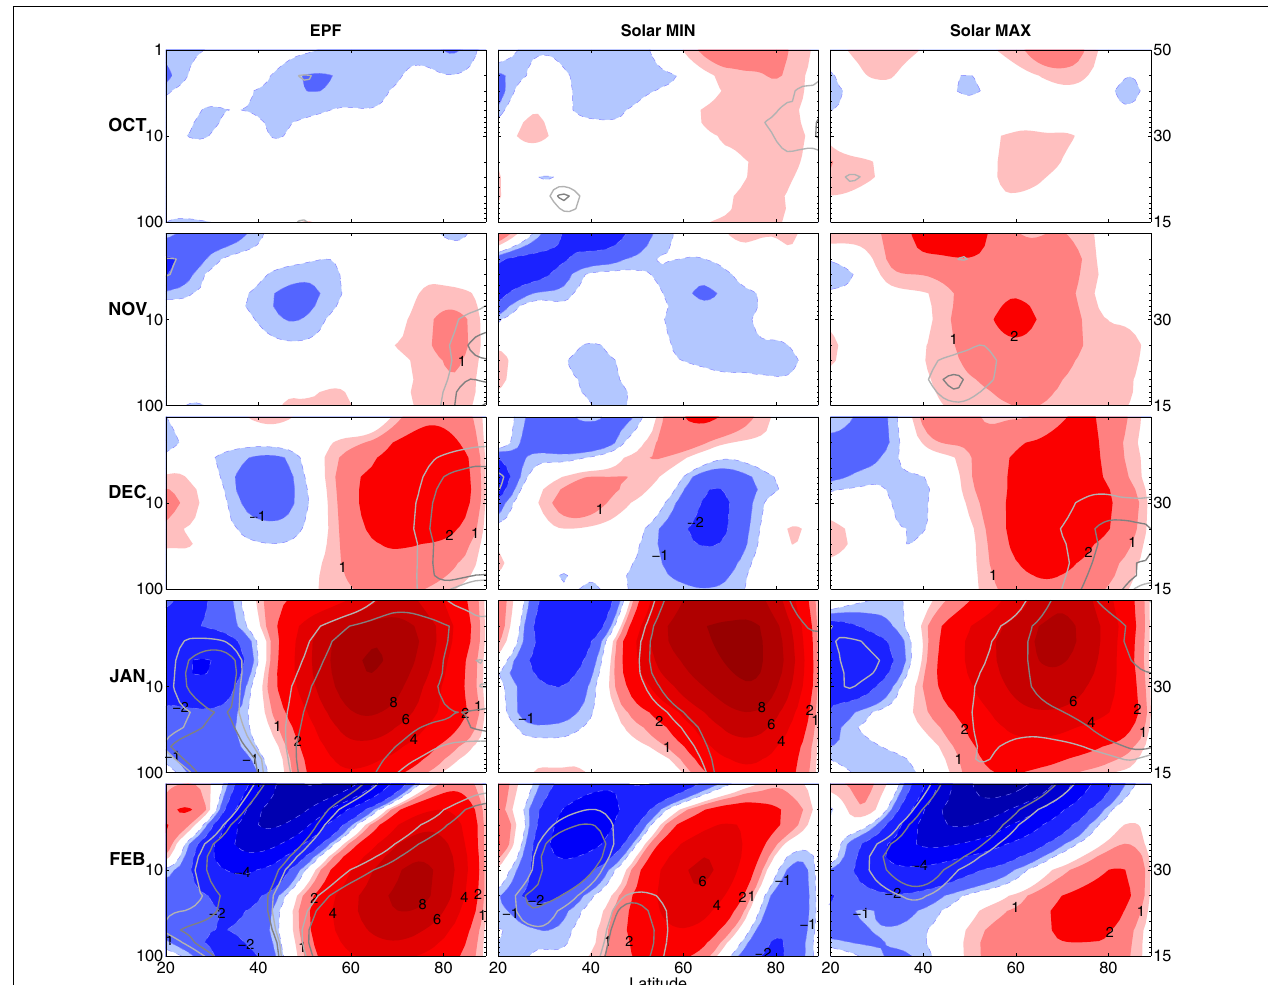
FIGURE 2 | Oct–Feb monthly Northern Hemisphere stratospheric 100–1hPa zonal mean zonal wind (U) anomalies (difference from the ERA mean) for high EPF (left), solar minimum (middle) and solar maximum (right) conditions. Contour lines are shown for ± 0.5, ± 1, ± 2, ± 4, ± 6, ± 8, ± 10, and ± 12m/s. Negative values are